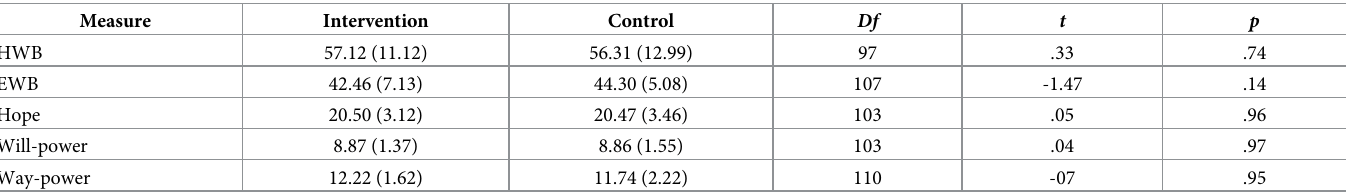
Table 1. Unadjusted pretest mean (and SD) Scores for HWB, EWB and hope scales by condition.